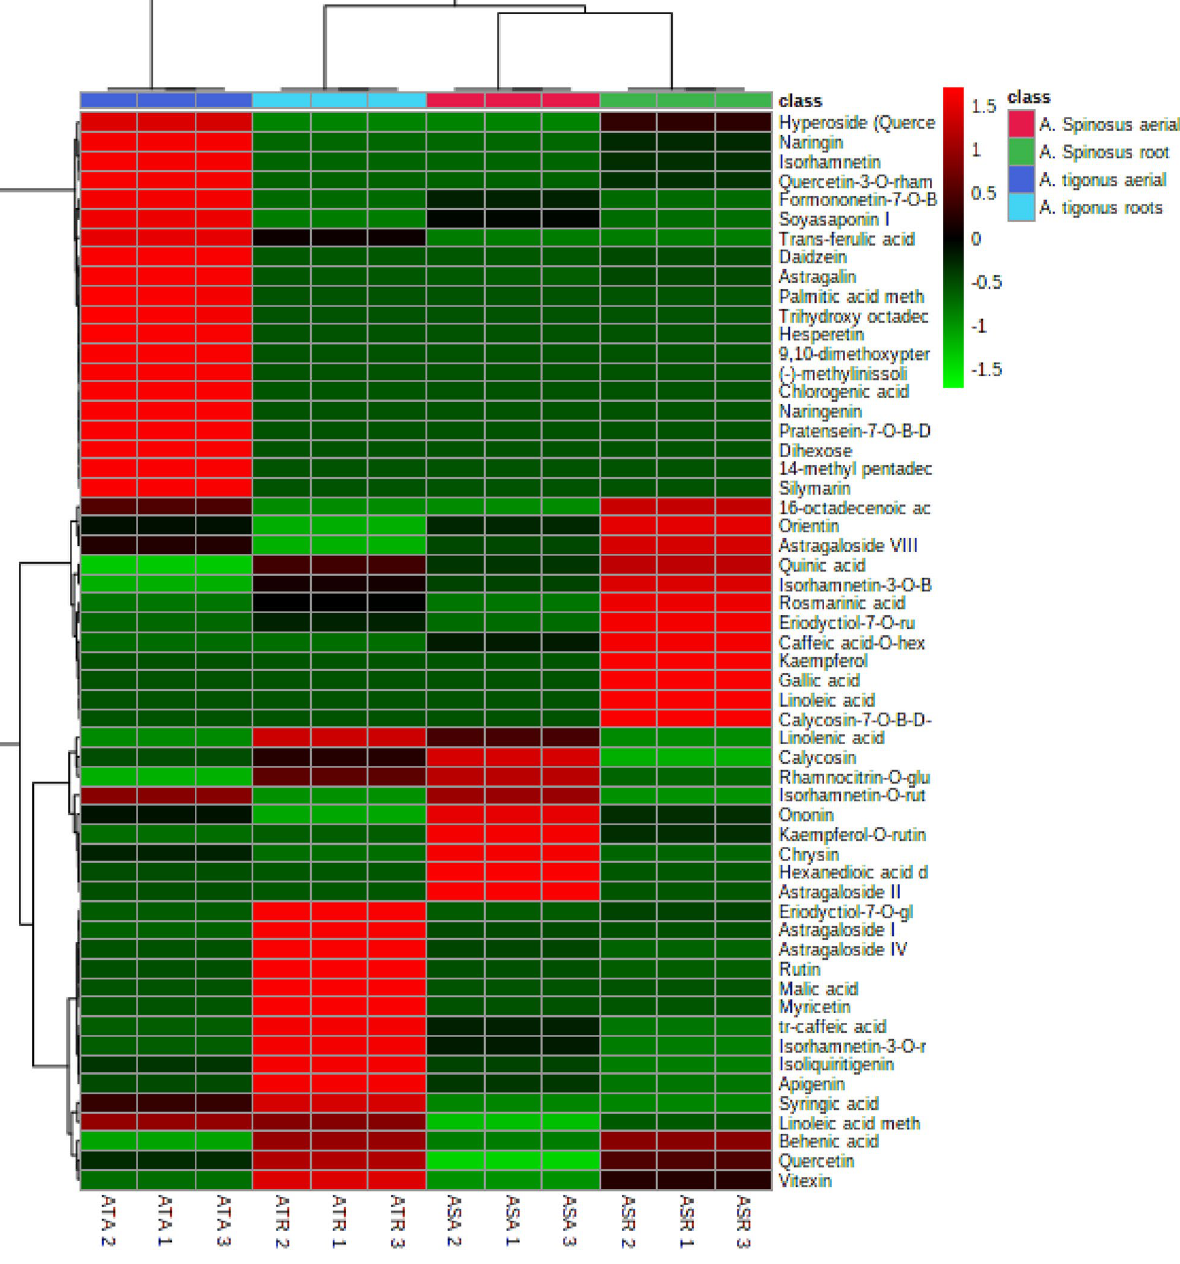
Figure 3. HCA- heat map showing the most discriminatory metabolites in each Effect of Different Astragalus Extracts on Portal Hypertension Markers. In the present study, the circulating level of apelin was significantly increased in rats with induced cirrhosis compared with healthy rats ( p < 0.001). With exception for At-ar-D1, all tested doses of all extracts significantly decreased serum apelin compared to rats with untreated induced cirrhosis. The least mean apelin value was observed in sera of rats treated with As-ar-D3, however, this mean value was not statistically different from those of the highest tested dose of other extracts. Hepatic DDAH-1 was significantly decreased in rats with cirrhosis compared to normal rats ( p < 0.001). High doses and some medium doses of different extracts were able to significantly increase hepatic DDAH-1, Fig. 8A. The highest mean hepatic DDAH-1 was observed in At-ar-D3 treated rats which was significantly higher than As-rt-D3 and At-rt-D3 ( p = 0.007 and 0.042, respectively), but showed no statistically significant difference with As-ar-D3 ( p = 0.897). According to the OPLS model, apelin is more significantly reduced in response to quinic acid (detected in all extracts), isorhamnetin-3-O-B-D-glucoside (present in all extracts except for As-ar) and caffeic acid-O-hexoside (present only in At-ar) , Figs. 8B1, S1D and supplementary Tables S1 and S3. The compounds that revealed the